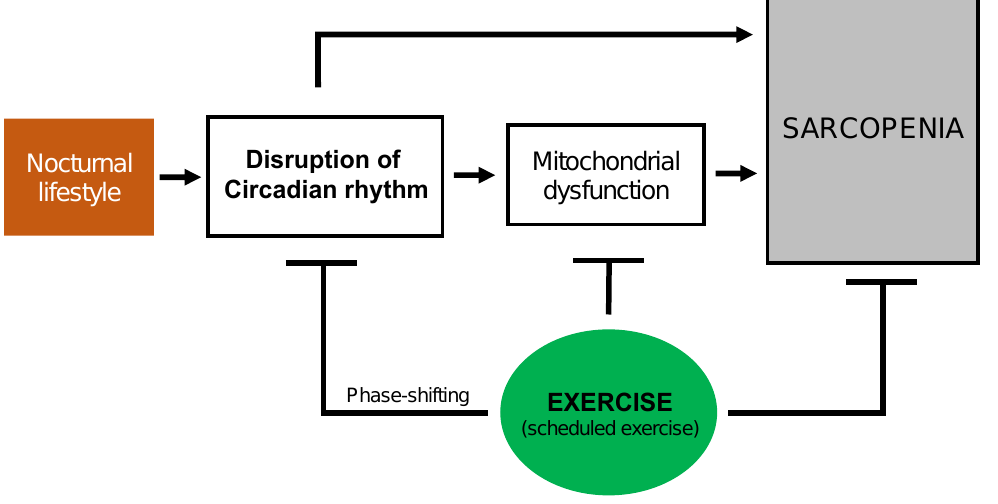
Figure 1. Schematic overview of the potential beneficial effects of exercise on circadian disruption and mitochondrial dysfunction associated with sarcopenia.